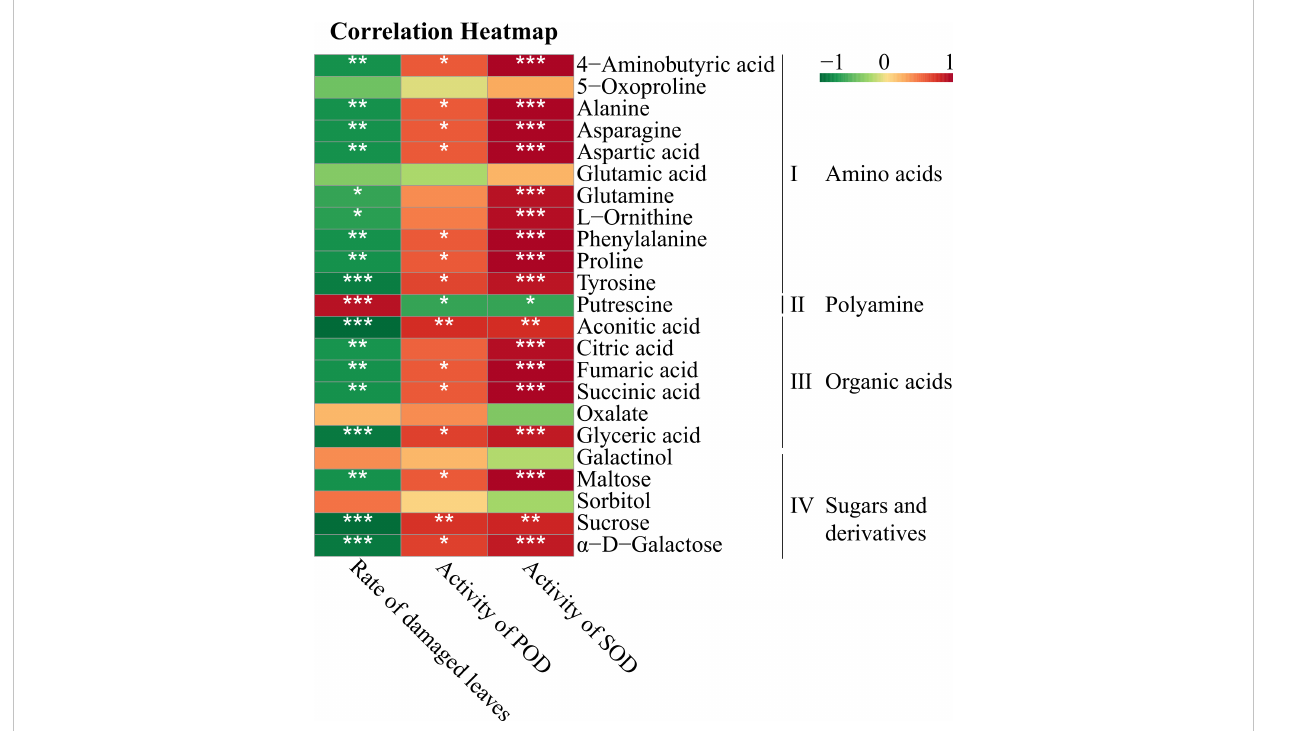
FIGURE 5 Spearman correlation analysis between the morphological and physiological responses and DAMs involved in the metabolic networks of the leaves. * Indicates a signi fi cant correlation at p < 0.05, ** indicates a signi fi cant correlation at p < 0.01 and *** indicates a signi fi cant correlation at p < 0.001. Red boxes represent positive correlations, green boxes represent negative correlations, and the depth of the colour represents the degree of the